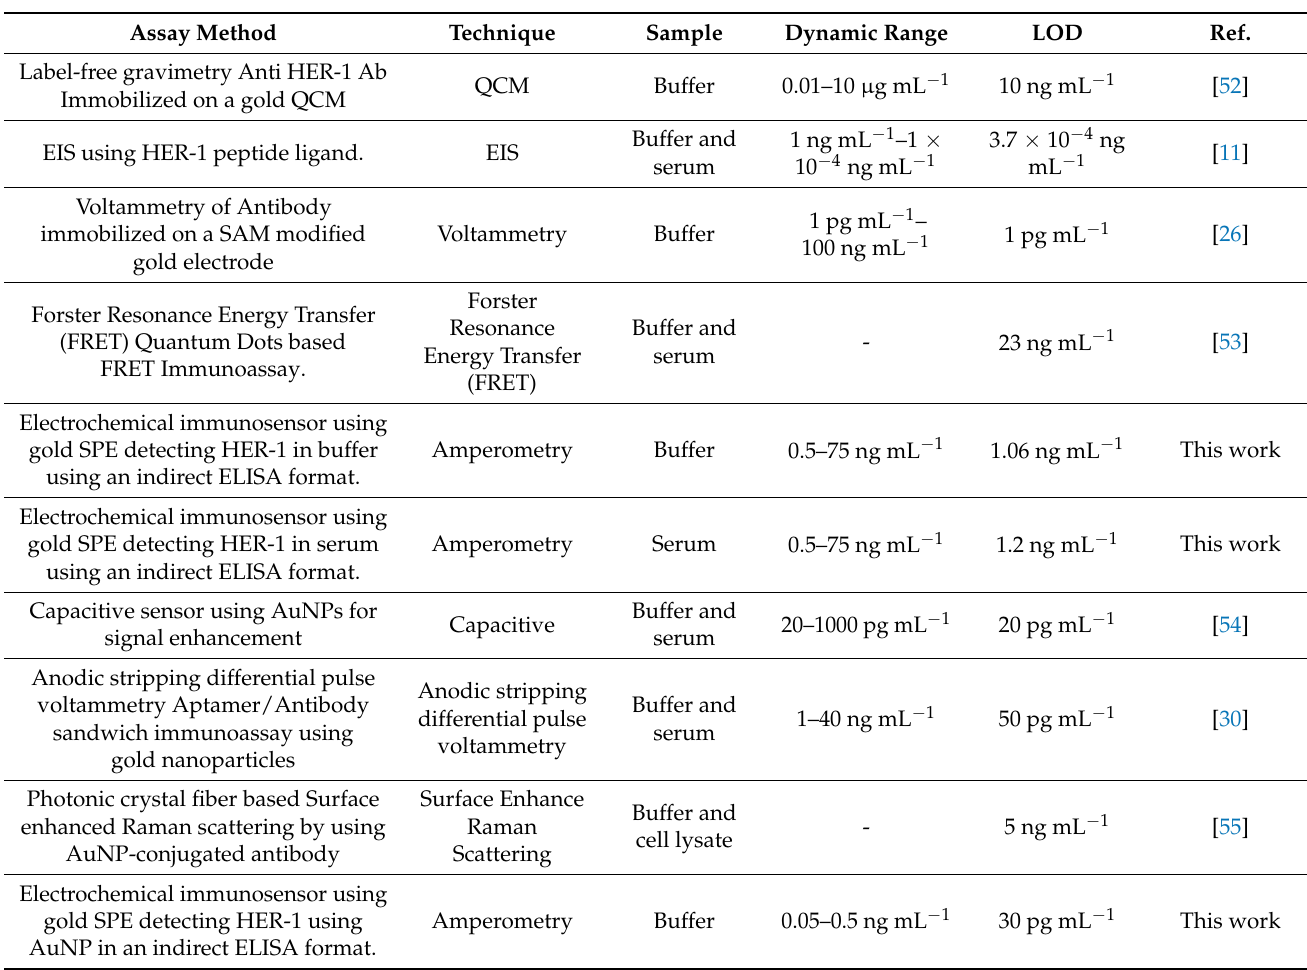
Table 1. Comparison of the performance of the sensor developed in this work for HER-1 (EGFR) with others reported in the